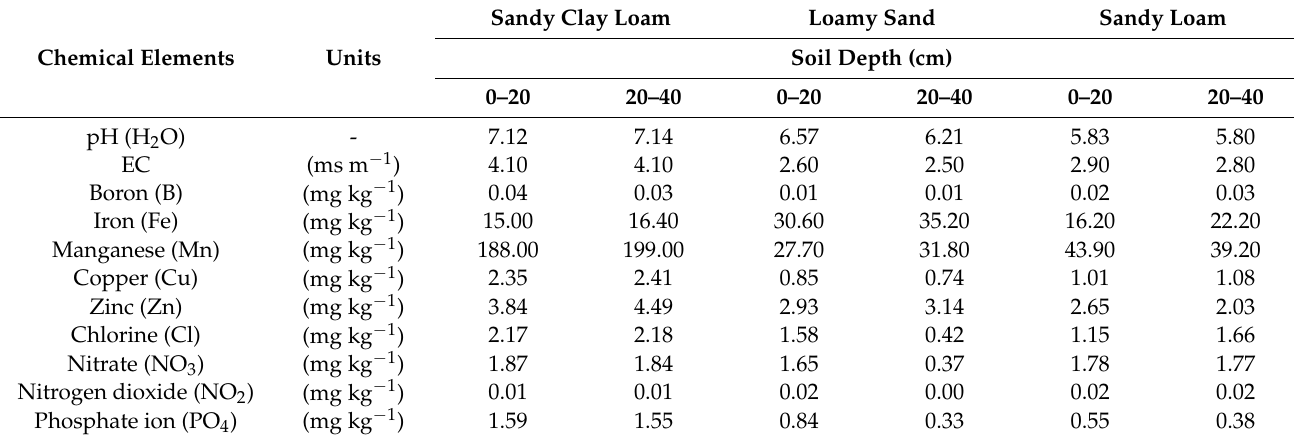
Table 10. Chemical properties of the experimental soils.